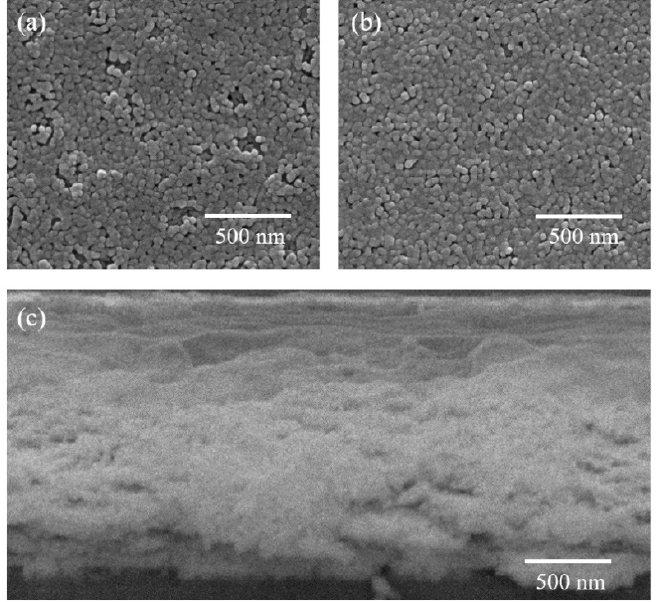
Figure 5. The microstructures of ( a ) the lithium-supplemented (#700-IL) and ( b ) unsupplemented (#700-I) In-doped LLZO–LZO samples annealed at 700 ◦ C, and ( c ) the SEM cross-sectional photo of sample